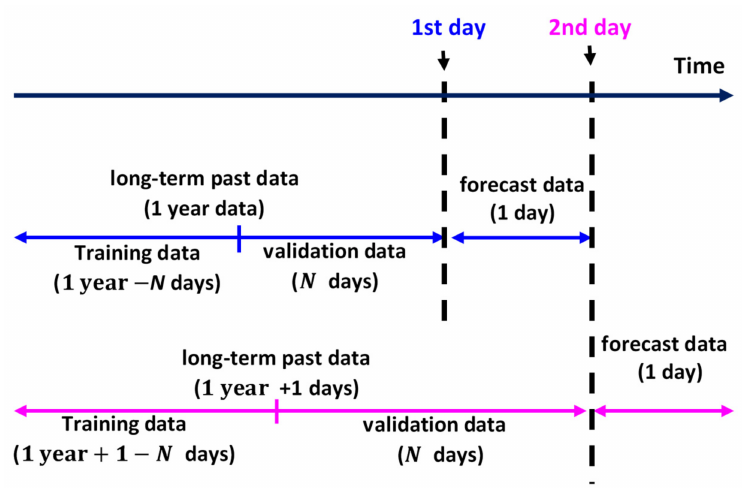
Figure 4. Data configuration; long-term past data for training and error validation. Forecast data for forecasting unknown PV